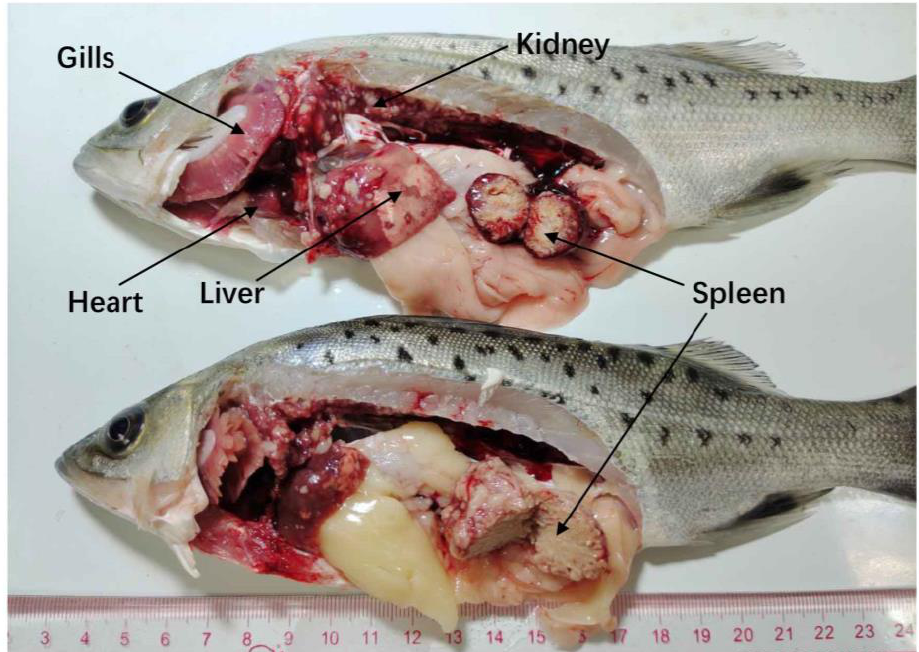
Figure 1. Gray-white nodules in the liver, spleen, and kidney tissues of Japanese seabass infected with M. marinum . Both fish were infected and their spleens were caseous necrosis.